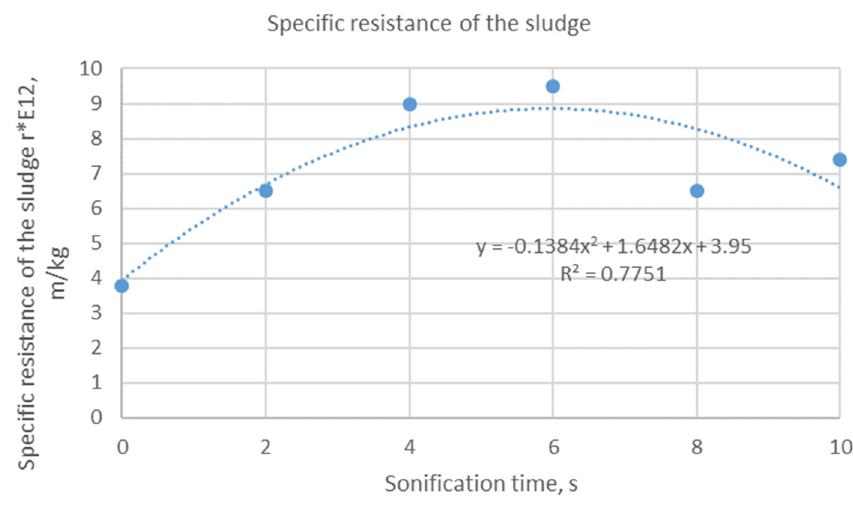
Figure 5. Final hydration of sewage sludge conditioned with sonicated polyelectrolyte.